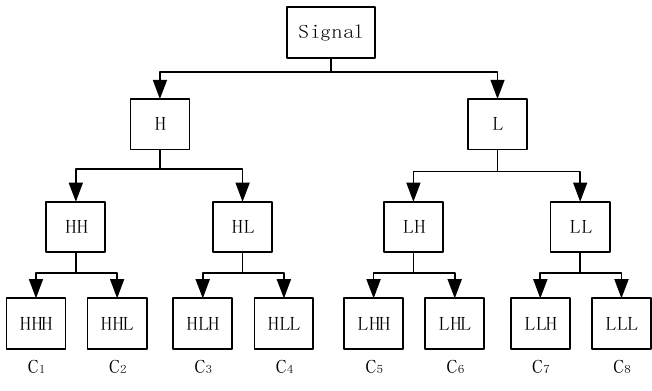
Figure 10. The decomposed diagram of the three layers wavelet.